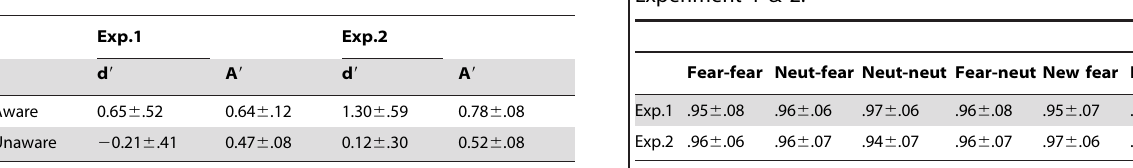
Table 2. Response accuracy under each condition for Experiment 1 &